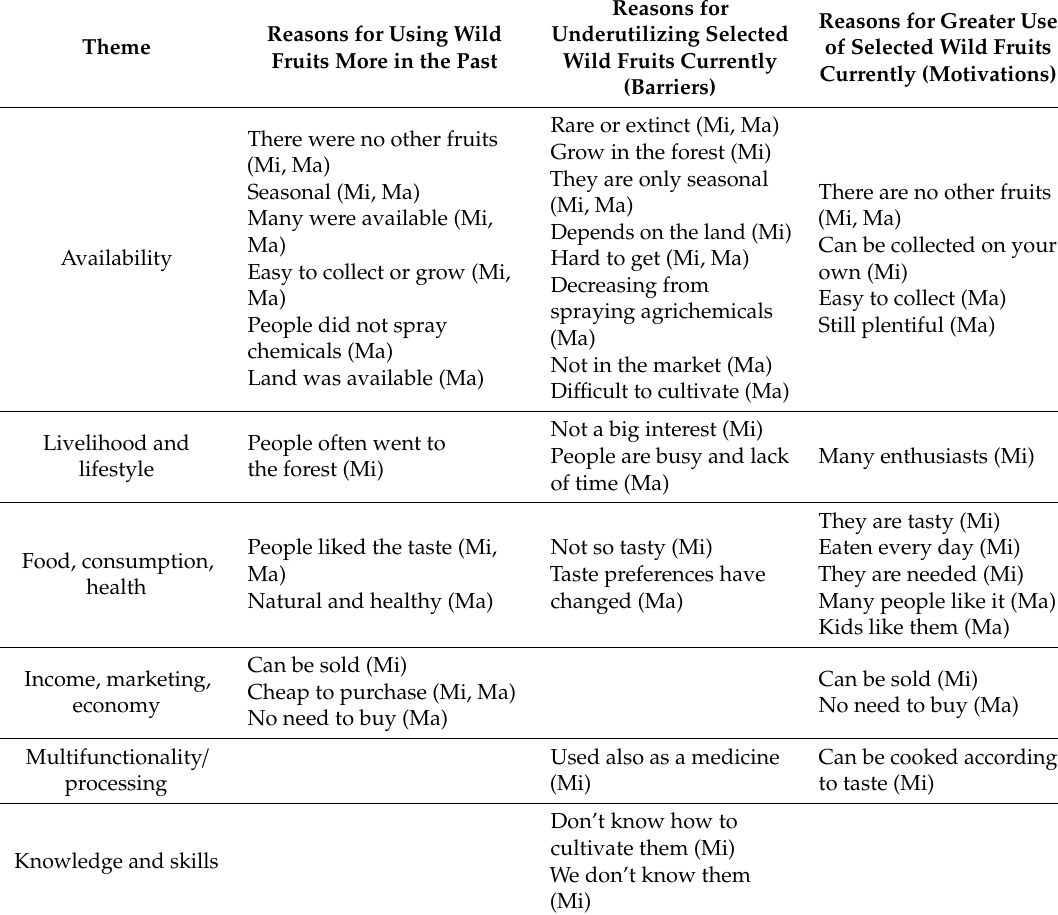
Table 3. Barriers, motivations and reasons for the changes in the use of wild